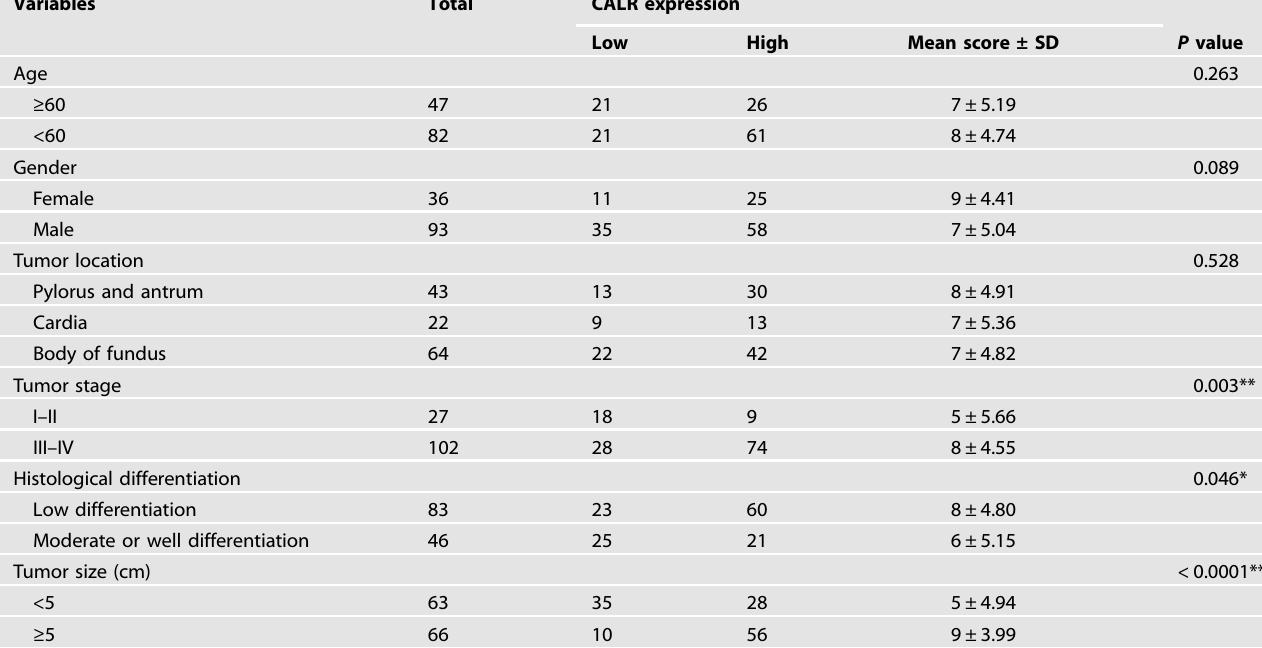
Table 1. Relationships between CALR expression (qRT-PCR) in GC tissues and various clinicopathological variables.